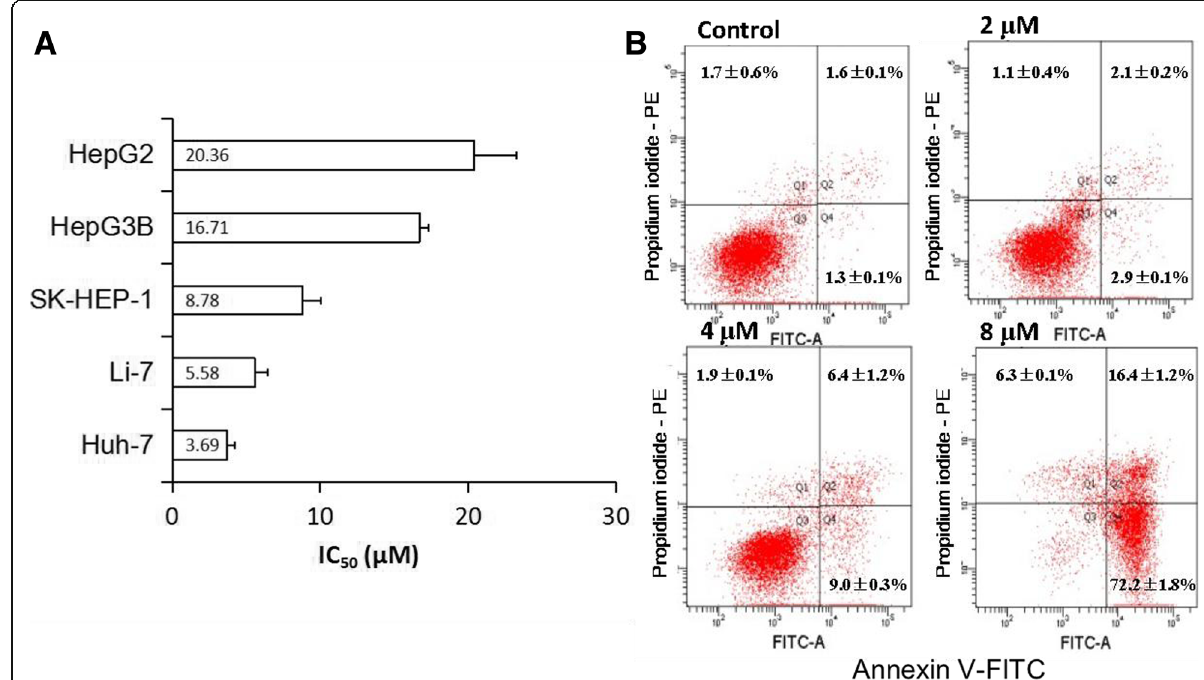
Fig. 3 2-Ethoxystypandrone (1) inhibited cell proliferation and induced apoptosis of HCC cells. a . IC 50 values of 2-ethoxystypandrone (1) on the viability of different human HCC cell lines. b HCC Huh-7 cells were treated with 2-ethoxystypandrone (1) at the indicated concentration for 24 h. After being stained with Annexin V-FITC and propidium iodide, cells were analyzed using flow cytometry. The percentage (%) of apoptotic cells was calculated with